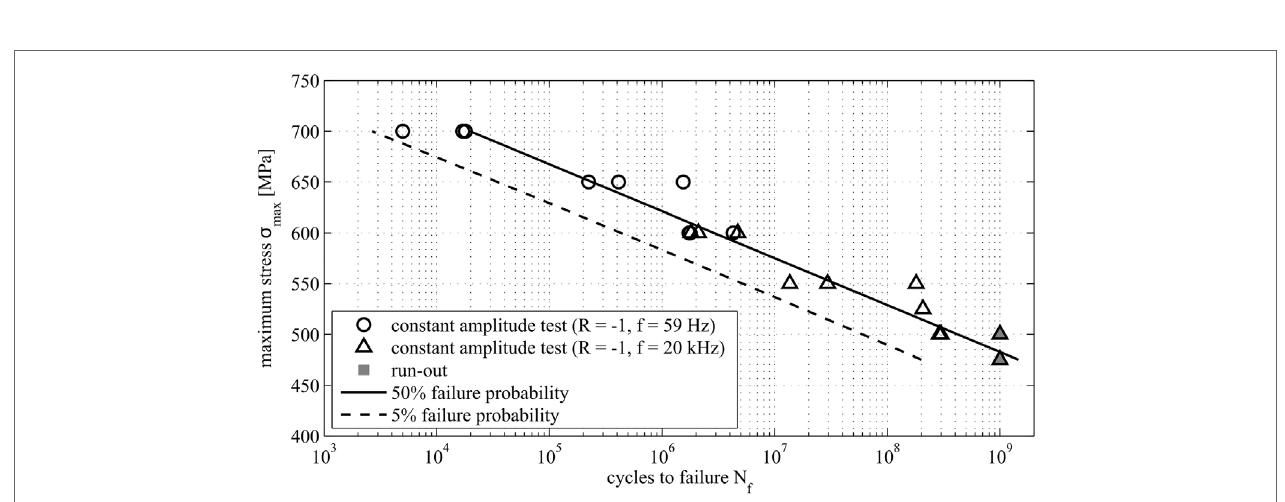
FigUre 7 | Very high cycle fatigue properties of hot-isostatic-pressed Ti–6al–4V under tension–tension loading .